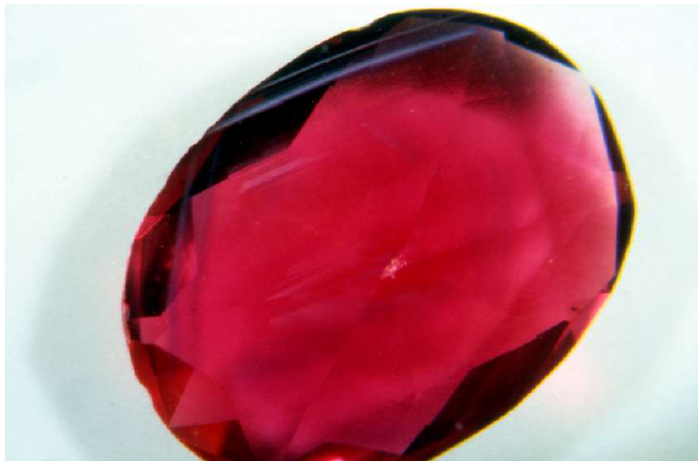
Figure 10. Facetted ruby (2.31c) from New England basaltic gem field [48]. Australian Museum Collection. Photo G. Webb, Australian Museum.